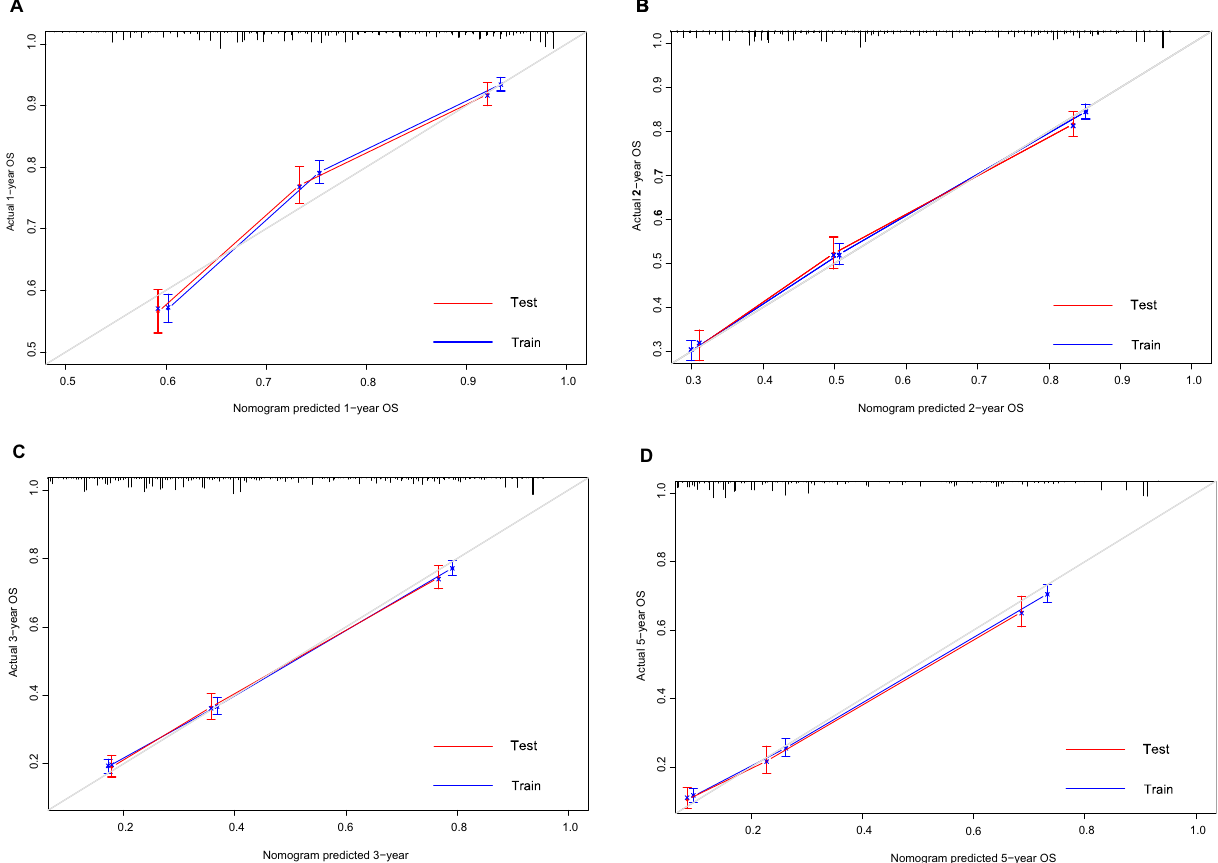
Figure 4. Calibration curves of the nomogram in the training cohort and validation cohorts. Calibration curves of 1-year ( A ), 2-year ( B ), 3-year ( C ) and 5-year ( D ) OS for patients in the training and validation cohorts. The plots along the 45° line indicate an appropriate calibration model, in which the predicted probabilities were identical to the actual outcomes. OS Overall